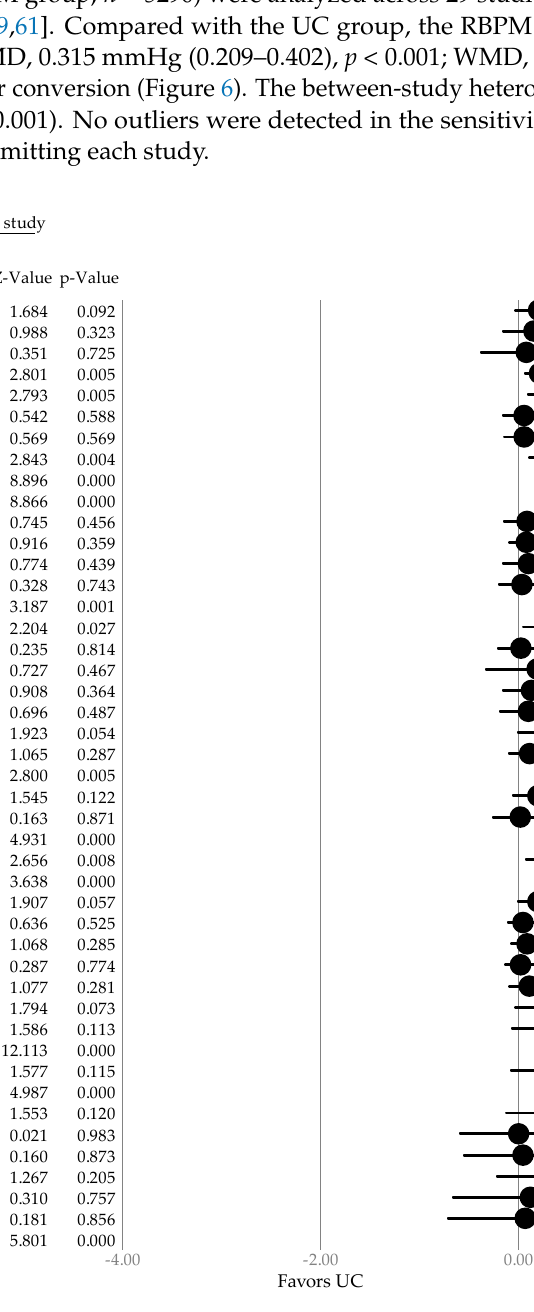
Figure 6. A forest plot of standardized mean difference in diastolic blood pressure. Note: point estimate of individual study ( ● ), summary effect size ( ◆ ); DBP, diastolic blood pressure; UC, usual care; RBPM, remote blood pressure monitor- ing.